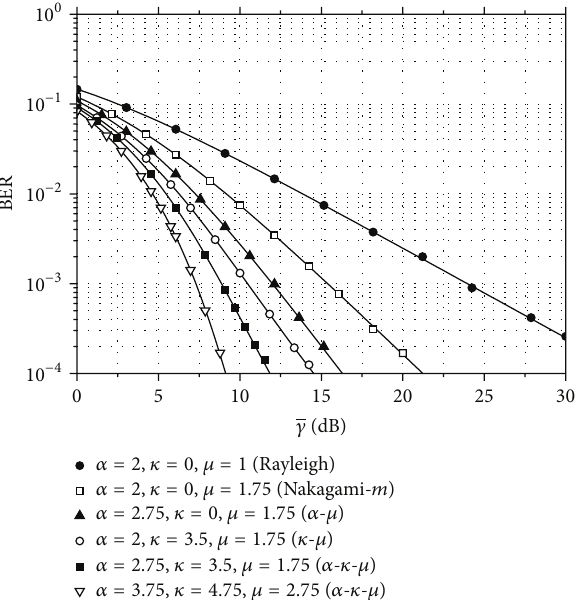
Figure 9: Average error probability for BPSK with 𝛼 - 𝜅 - 𝜇